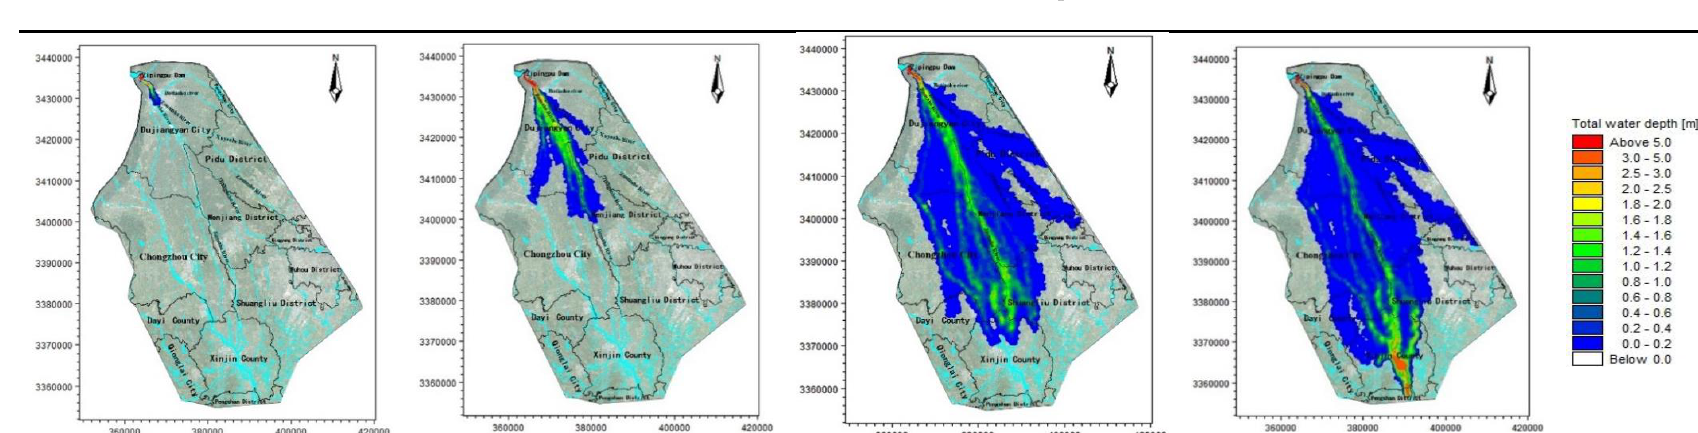
Figure 3. Scenario 1: Inundation at four time points.